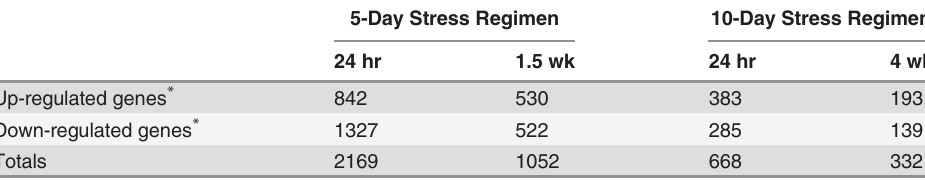
Table 1. Summary of differentially expressed genes between livers of Control and AggE